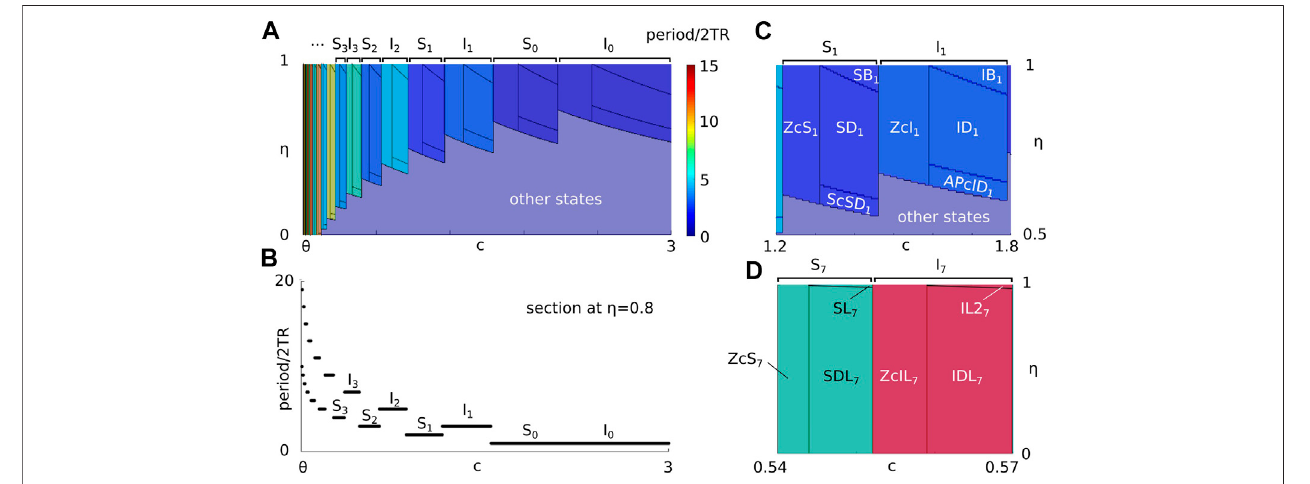
FIGURE3|(A) Regionsofexistenceofcycleskippingstatesinthespaceofparameters( c , η ),wherecolorsshowthestates ’ periods(scaledby2 TR ). (B) Sectionof panelAat fi xed η (cid:2) 0.8showsthedependenceofstates ’ periodon c . (C) ZoomofpanelAshowingthesubdivisionofexistenceregionsforstatesingroups S 1 and I 1 . (D) Zoom of panel A showing the subdivision of existence regions for states in groups S 7 and I 7 . Model parameters are the same as in Figure 1F .